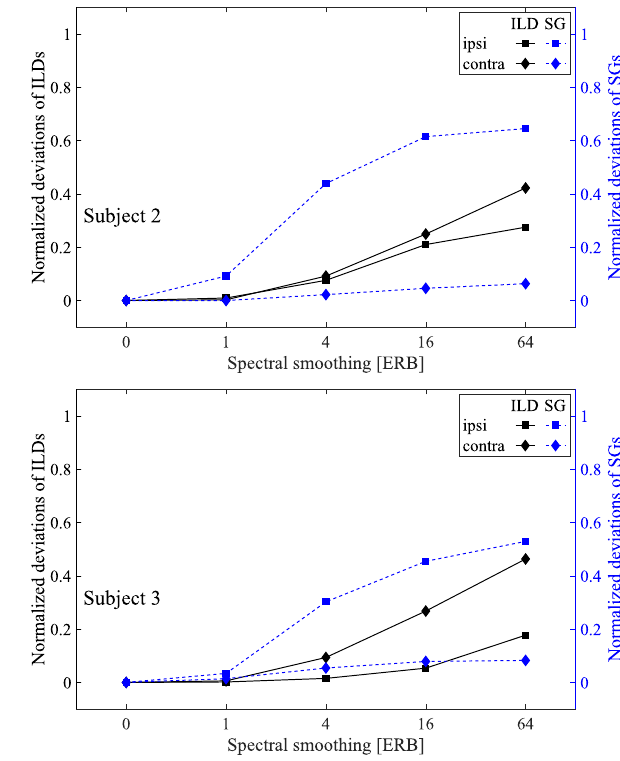
Figure 11. Deviation of normalized ILDs (solid lines) and SGs (dashed lines) of the individually synthesized binaural signals for subject 2 (upper panel) and subject 3 (lower panel) under different